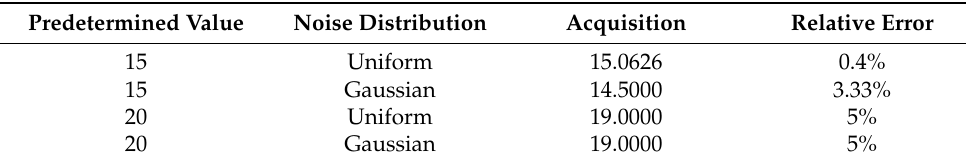
Table 2. The results of viscous damping coefficient without leakage.